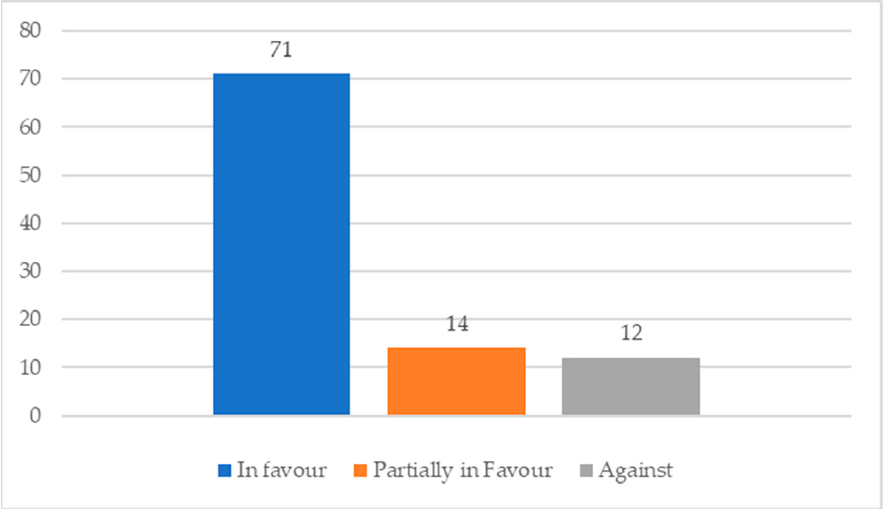
Figure 7. How the court has adjudicated the claim? As Figure 7 indicates, most decisions were in favour of the right to water as defined by the court. We decided to classify the decisions as in favour, partially in favour, or against regarding the protection of the right to water as defined by the court because to classify the decisions as favourable or against the claim could lead to confusing results depending